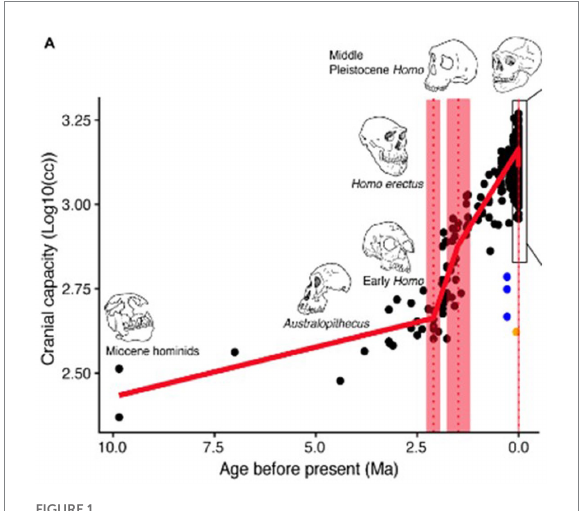
FIGURE 1 Evolution of human brain size over the past 10 million years, from DeSilva et al.,